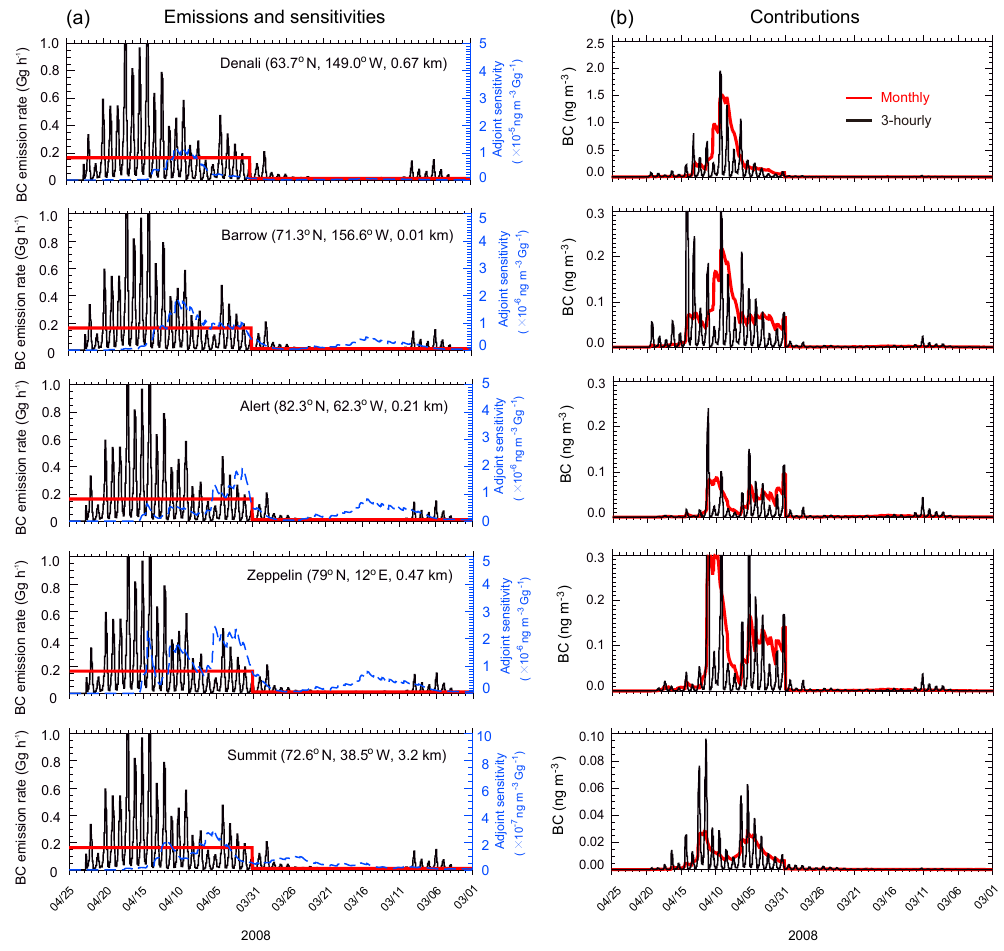
Figure 8. (a) Biomass burning BC emission rates (Ggh − 1 , red – monthly, black – 3-hourly) in Siberia (see Fig. 2) for April 2008 and (b) con- tributions (ngm − 3 ) to BC at the five sites from Siberian biomass burning emissions (red – monthly, black – 3-hourly) during 1 March– 25 April. Emission data are from the Global Fire Emissions Database version 3 (GFEDv3) inventory (Randerson et al., 2012). Adjoint sensitivities of mean BC during 20–25 April 2008 at the five sites (see Fig. 1) to Siberia biomass burning emissions are also shown ( a , dashed